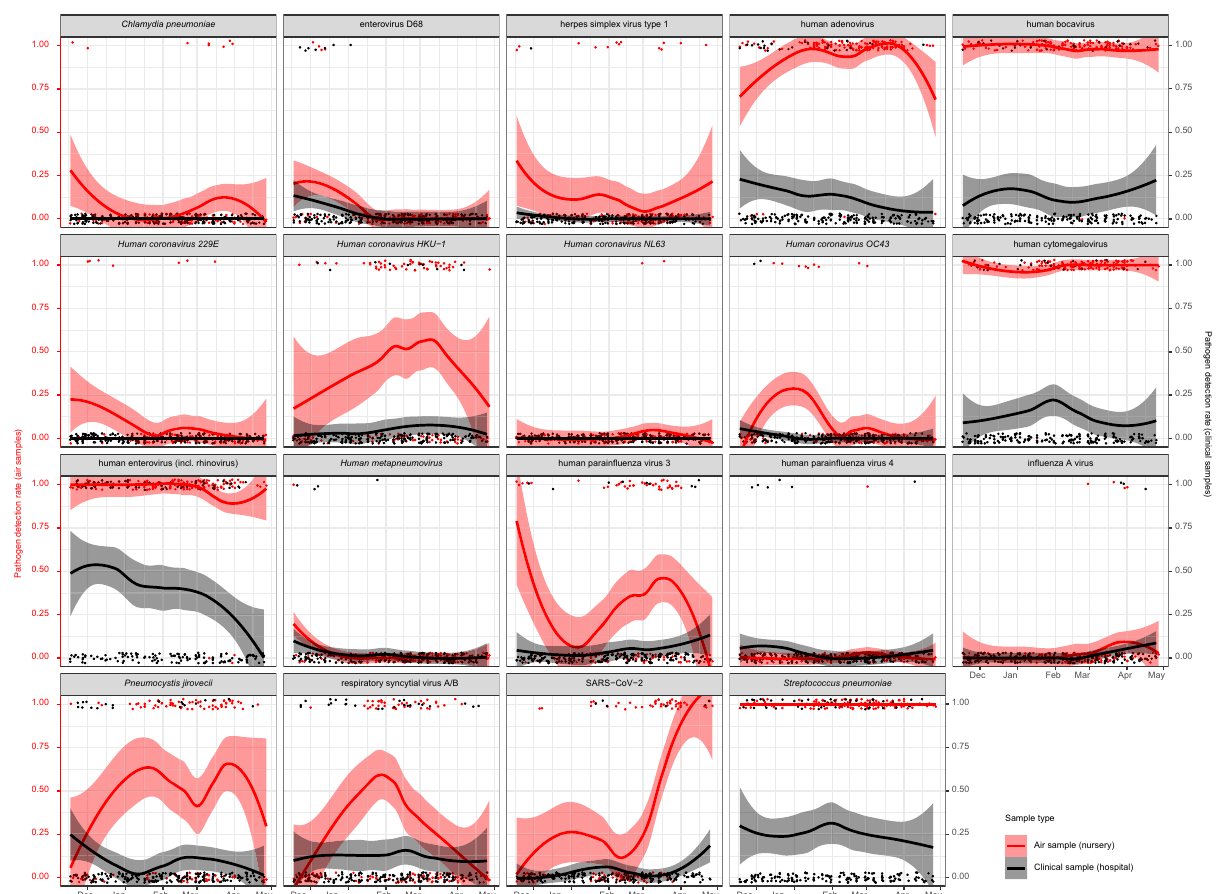
Fig. 1 | Positivity rates of respiratory pathogens in ambient air in nursery locations(red)comparedtoclinicalsamplesfromalocalhospital(black/grey). Each panel represents qPCR test results of one of the 29 targeted pathogens, plotted by sampling date. Each pathogen which was positive in at least one air sampleisshown.ForSARS-CoV-2,theTaqPathresultsareshown.Theindividualred datapoints represent the positive and negative ambient air samples taken in a nursery (0=negative, 1=positive). This was the most stable age group regarding sampling frequency, occupancy and the continued presence of the same group of individuals (Supplementary Fig. 1). Red lines and shaded areas show a corre- sponding LOcally weEighted Scatterplot Smoothing (LOESS) regression of the positivityrateforeachpathogenwith95%con fi denceintervals.Weincluded121air